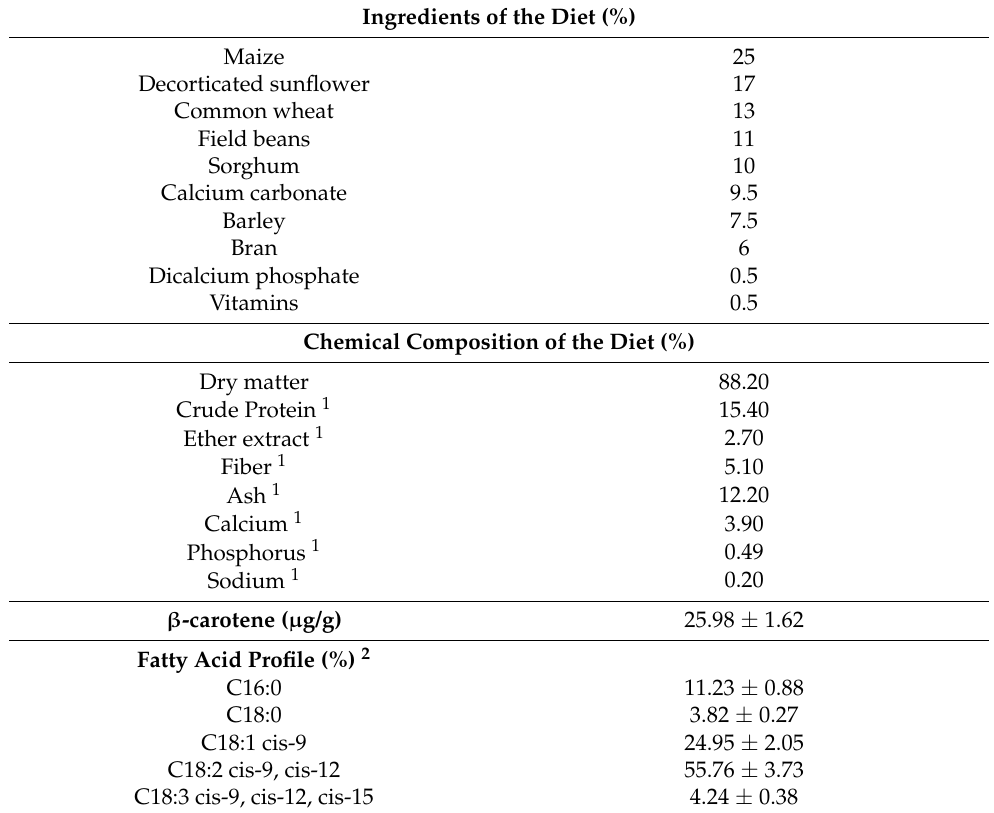
Table 1. Chemical composition and fatty acid profile of the diet administered to the animals involved in the